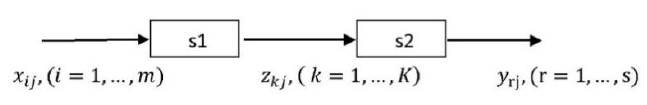
Fig. 1. Basic two-stage network